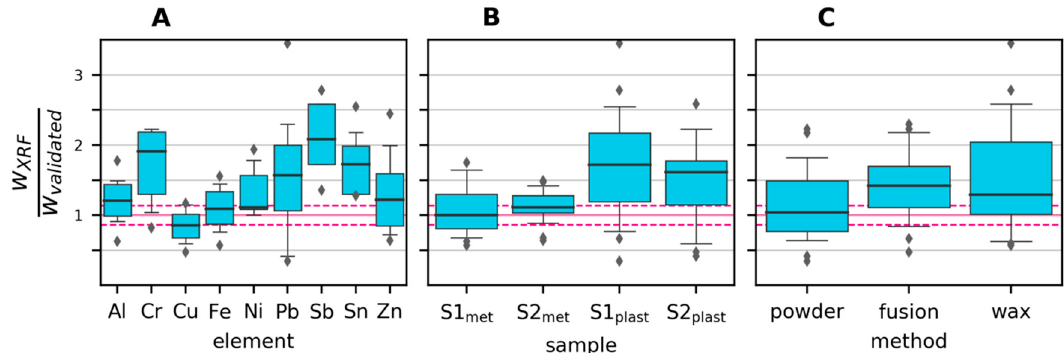
Figure 5. Mass fractions ( w ) measured by XRF divided by mass fractions measured by the validated method. The median is shown as a thick blue line, boxes represent the 25th to 75th percentile, whiskers represent the 5th and 95th percentile, and outliers are shown as circles. The horizontal pink dashed lines show the relative standard deviation of the validated measurements across all elements. ( A ): grouped by element; ( B ): grouped by sample; ( C ): grouped by XRF sample preparation